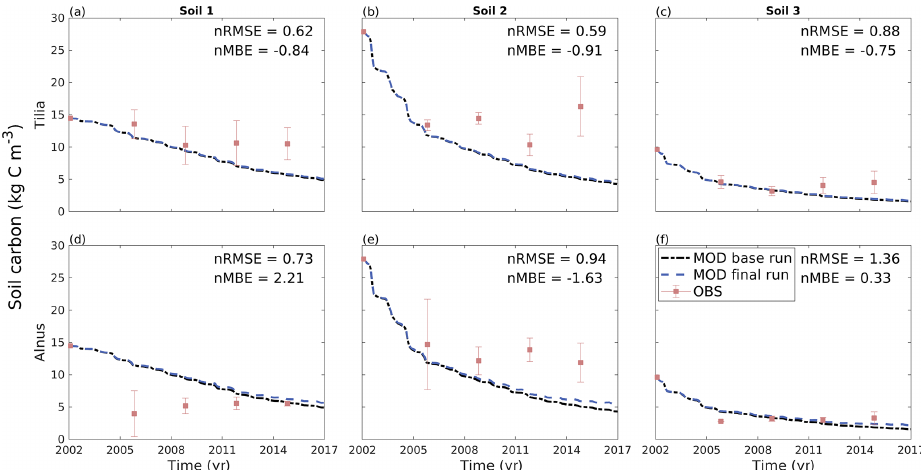
Figure 7. Monthly soil carbon stock modelled using Yasso without roots (dashed black line) and with roots (dashed blue line) from 2002 to 2016, and measured average loss-on-ignition-based soil carbon stock estimations ( ± SD; red dots) for the three studied soil types at the Tilia site (a–c) and the Alnus site (d–f)